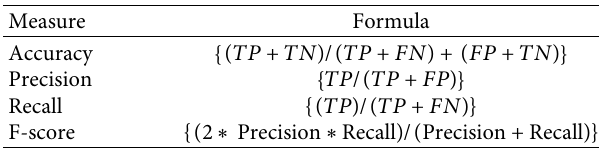
Table 4: Evaluation measures.